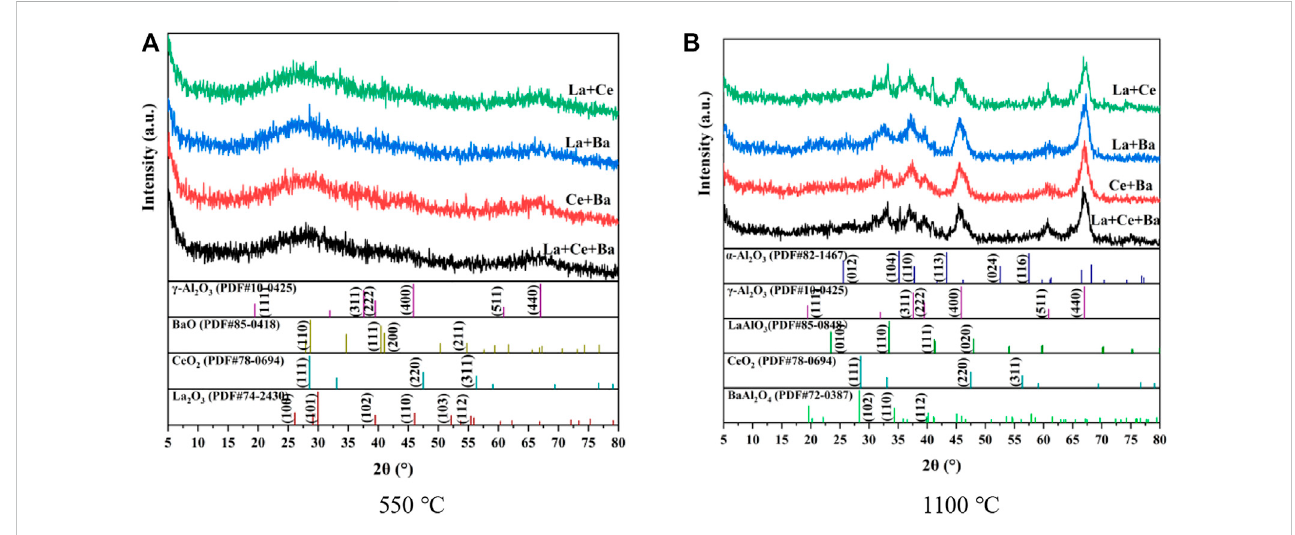
FIGURE 6 XRD pattern of mixed doping after calcination at 550 ° C and aged at 1,100 ° C.